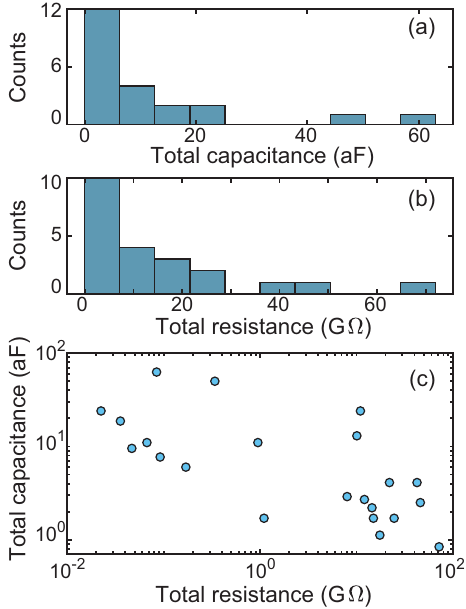
Figure 4. Total capacitances ( C = C 1 + C 2 ) and total resistances ( R = R 1 + R 2 ) calculated with the orthodox Coulomb blockade model for the 22 devices showing Coulomb-blockade at temperatures below 100 K. Table S1 contains the entire set of Coulomb blockade parameters used to model each device, at the lowest recorded temperature. ( a ) Total capacitance histogram. ( b ) Total resistance histogram. ( c ) Total capacitance plotted against the total